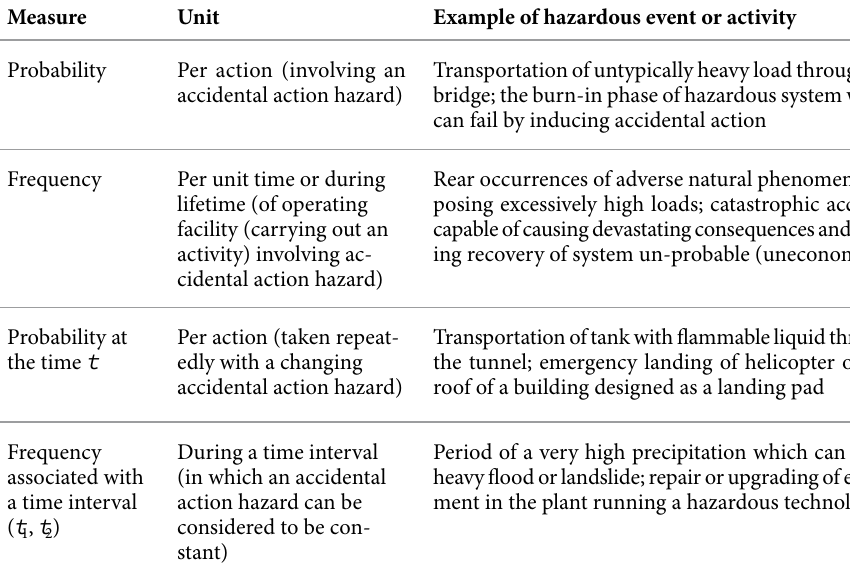
table 2. Specific form of the likelihood L i (Kumamoto and Henley 1996; Vaidogas 2003)